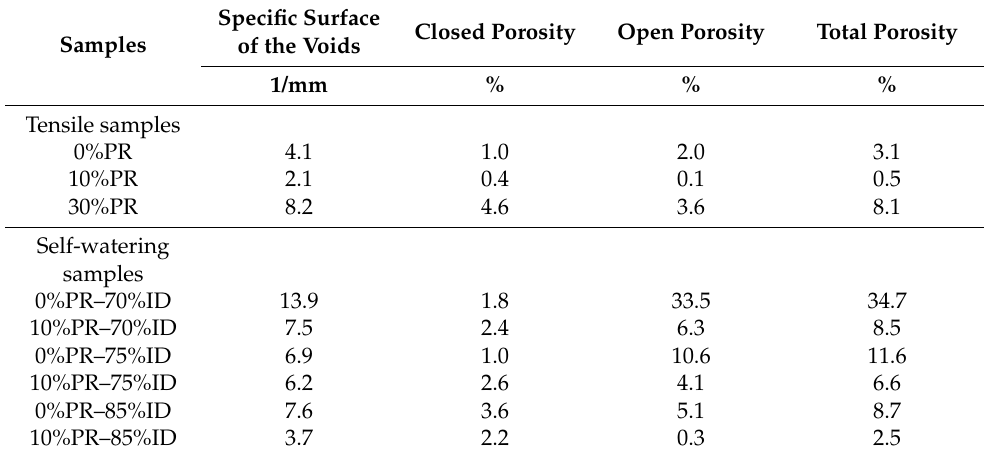
Table 6. Morphological parameters obtained with X-ray